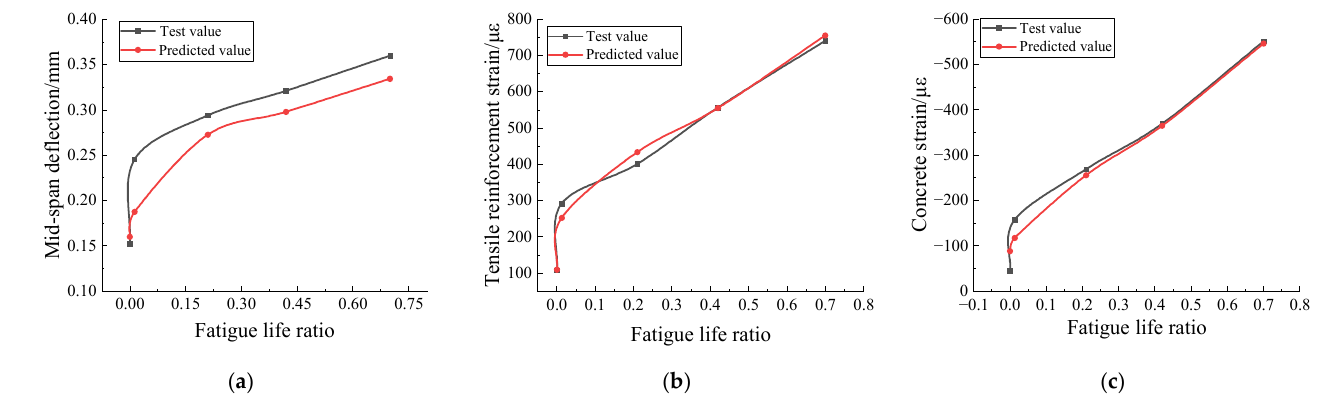
Figure 10. Analysis of fatigue loading process of RC-2 specimen beam: ( a ) mid-span deflection; ( b ) reinforcement strain; ( c ) concrete strain.